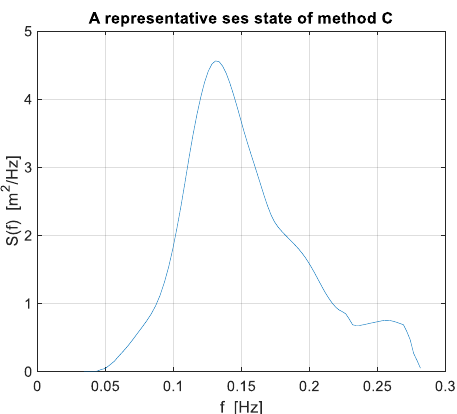
Fig. 9. A representative sea state of method C